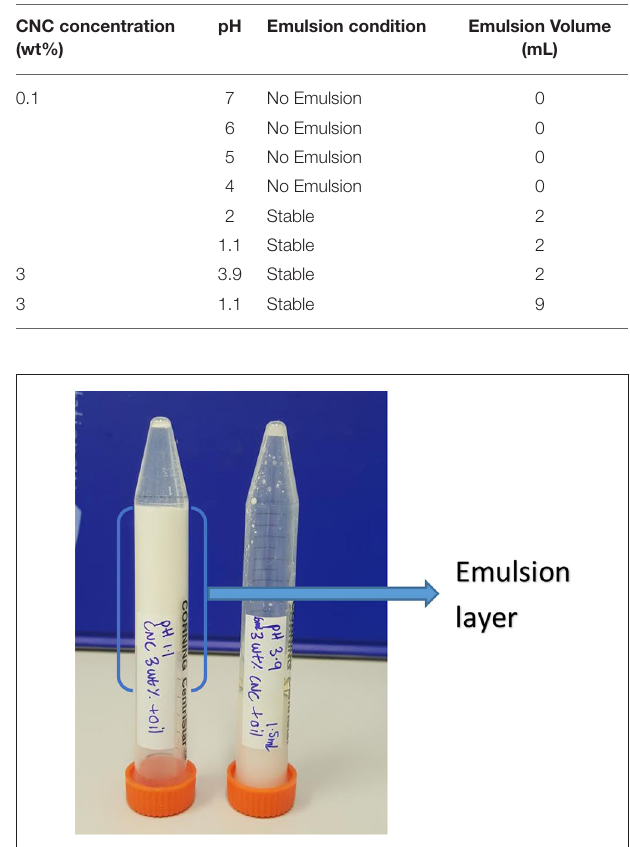
FIGURE 11 | Photograph of C. Oil/water emulsion with 3 wt% CNC and pH 1.1 and